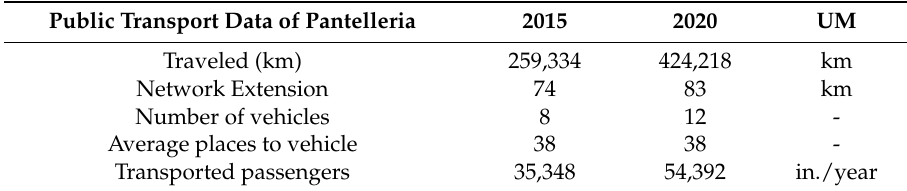
Table 9. Information of Public Transportation Lines in